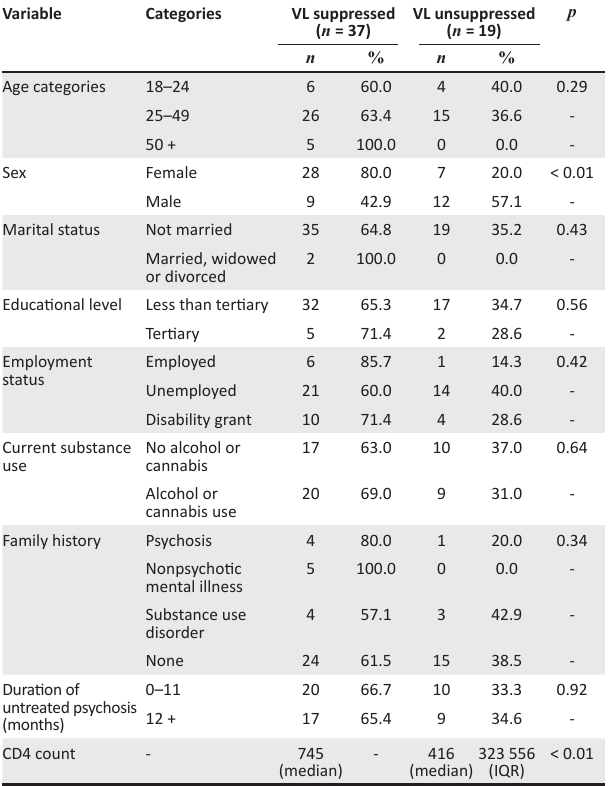
TABLE 3: Association between viral load and sociodemographic and clinical characteristics in people with recent onset psychosis and